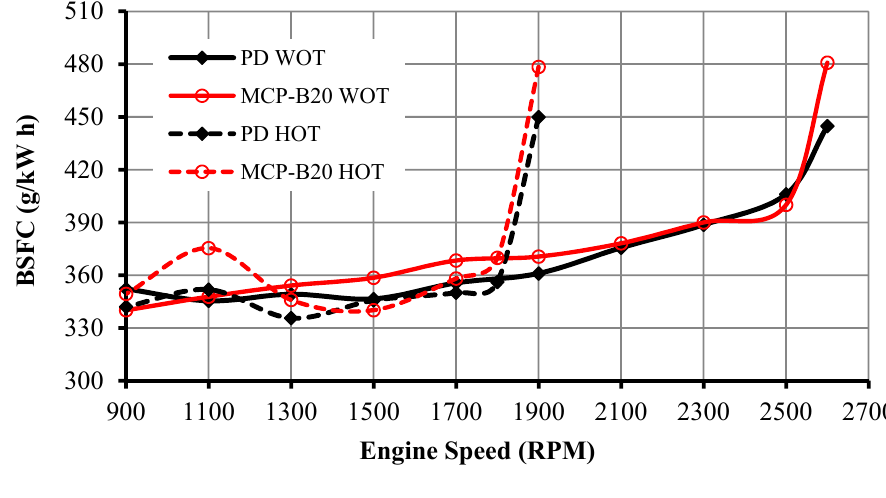
Figure 7. The relationship between tractor engine speeds (RPM) and engine BSFC (g/kWh) for PD and